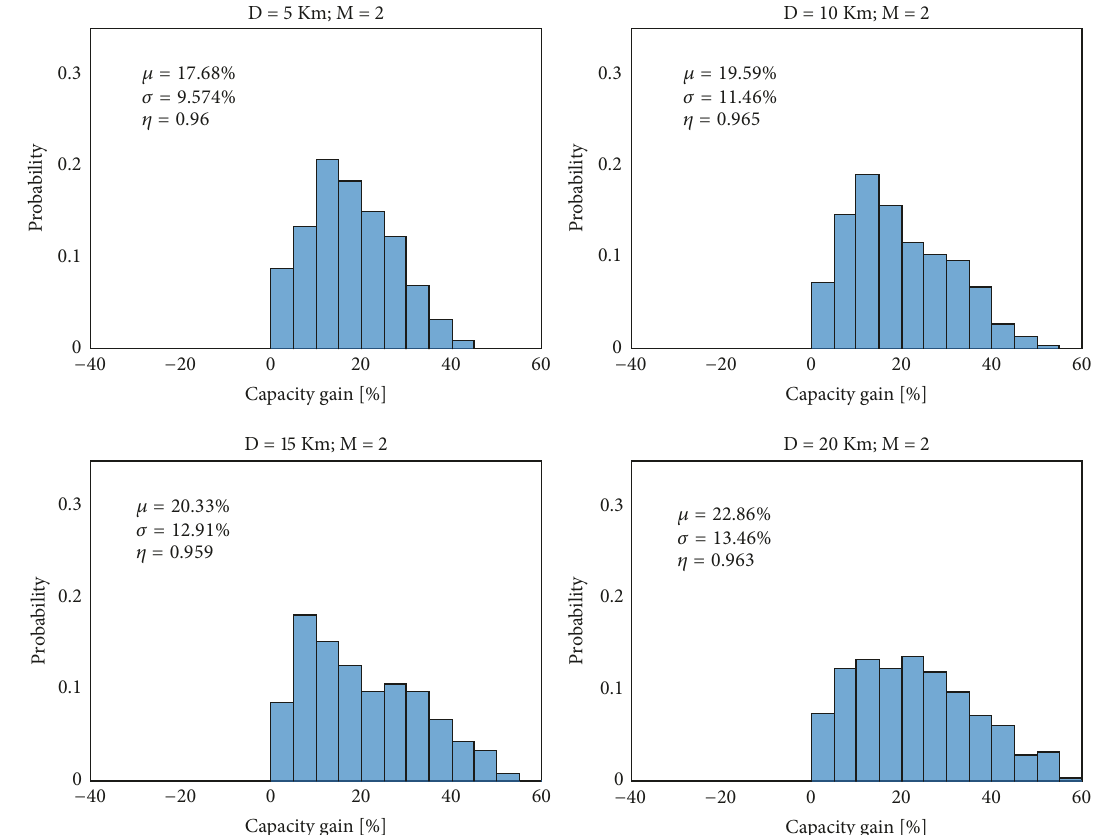
Figure 4: Distributions of the capacity gain for different corridor lengths when 𝑀 = 2